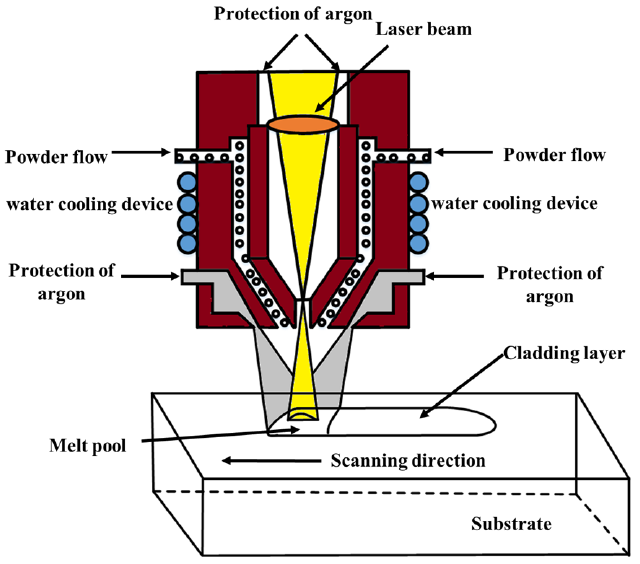
Figure 1. Laser cladding principle.